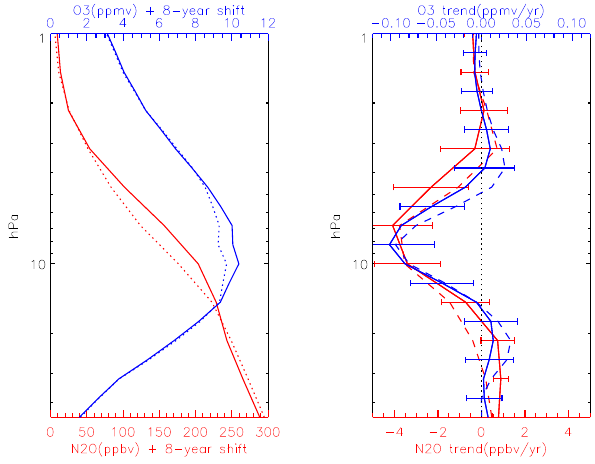
Figure 7. Left hand panel: annual average MLS profiles of O 3 (blue; top scale) and N 2 O (red; bottom scale) from 5 ◦ S–5 ◦ N. Shown are the constant term derived from the fit to the August 2004–May 2013 MLS measurements (solid), and the same term with an added 8-year shift (thus approximating the difference between the 2004– 2005 and 2012–2013 MLS annual average) based on the linear trend applied over a period comparable to the length of the MLS data set (dotted). Right hand panel: linear annual trend calculated with a solar cycle term included (solid) and without a solar cycle term (dashed). Error bars (2 σ) are similar for fits with and without the solar cycle, and are shown only for the